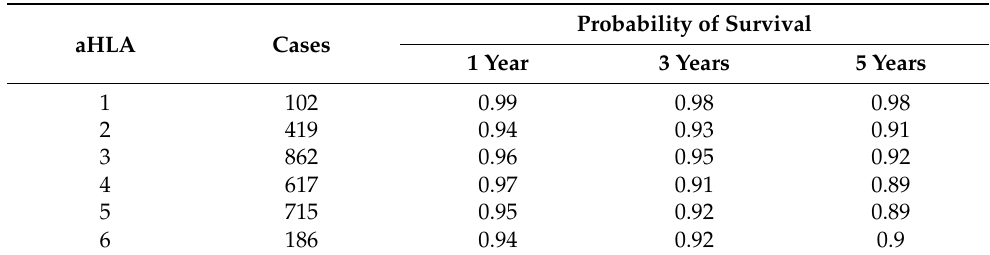
Table 3. Censored survival probability to renal graft failure at one, three and five years for SICATA from aHLA. Probability of Survival aHLA Cases 1 Year 3 Years 5 Years 1 102